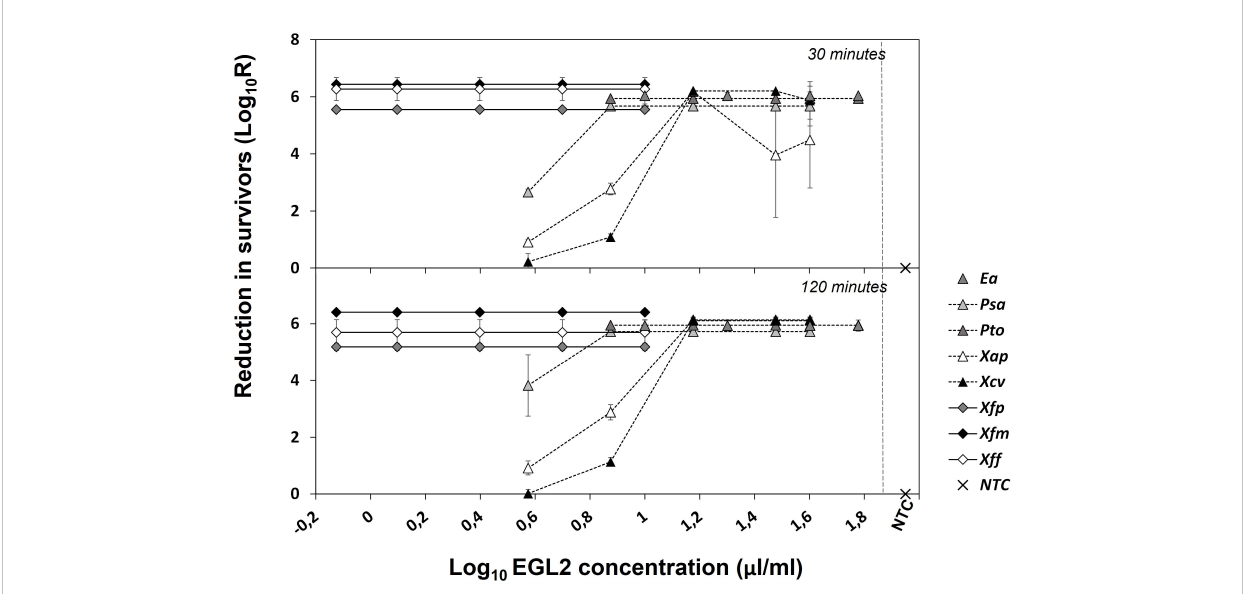
FIGURE 1 Effect of EGL2 in cell survival of different plant pathogenic bacteria after exposure to 30 or 120 minutes. Ea , Erwinia amylovora; Psa, Pseudomonas syringae pv. actinidiae; Pto, Pseudomonas syringae pv. tomato; Xap, Xanthomonas arboricola pv. pruni; Xcv , Xanthomonas campestris pv. vesicatoria; Xfp , Xylella fastidiosa subsp. pauca ; Xfm, Xylella fastidiosa subsp. multiplex; Xff, Xylella fastidiosa subsp. fastidiosa. Non-treated controls (NTC) were included. Values are the means of three replicates, and error bars represent the standard deviation of the mean. Most bacteria were highly susceptible to EGL2 with high reduction in survivors even at the lowest concentration of 0.75 µl/ml. Psa , Xap and Xcv were the less